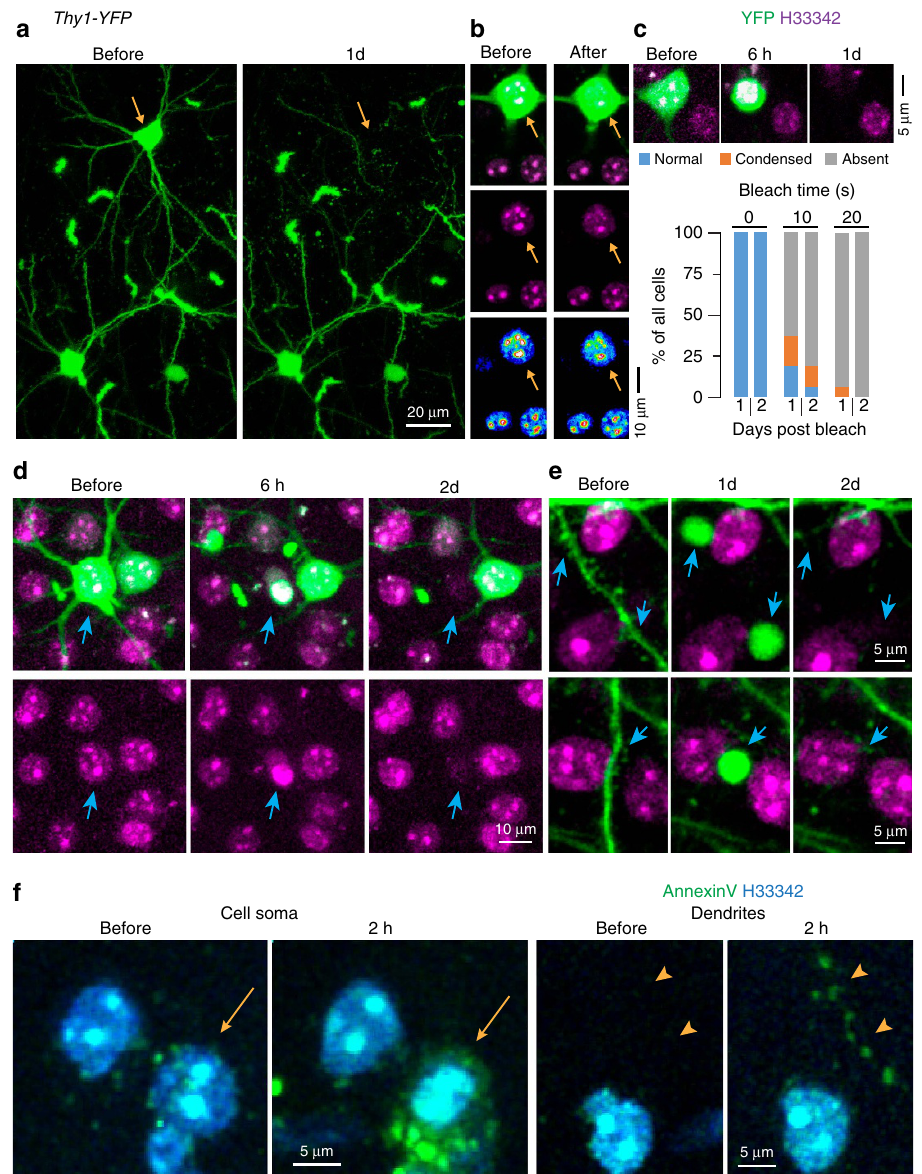
Figure 4 | Nuclear pyknosis and formation of apoptotic bodies in targeted neurons. ( a ) In vivo images captured from the cortex of a Thy1-YFP mouse showing single neuron ablation over 1 day (yellow arrows). ( b ) Photobleaching of H33342 causes no immediate changes in YFP labelling or cell soma integrity (arrow indicates bleached cell). ( c ) Laser scan time-dependent cell death induction 1 and 2 days after photobleaching, n ¼ 24 cells, 0s control; 16 cells, 10s scan; and 16 cells, 20s scan, from 4 mice. ( d ) Time-lapse sequence showing nuclear pyknosis and degeneration of cell soma and dendrites (blue arrows) after 2Phatal. Top panel shows combined YFP and H33342 signals, whereas bottom panels show only H33342 fluorescence. ( e ) Single dendrites imaged over 2 days showing their transformation into apoptotic bodies (arrows) during apoptosis of a single neuron after 2Phatal. ( f ) In vivo images showing a single neuron becoming labeled with Annexin V at the cell soma (arrows) and along single dendrites (arrowheads) n ¼ 15 cells from 4